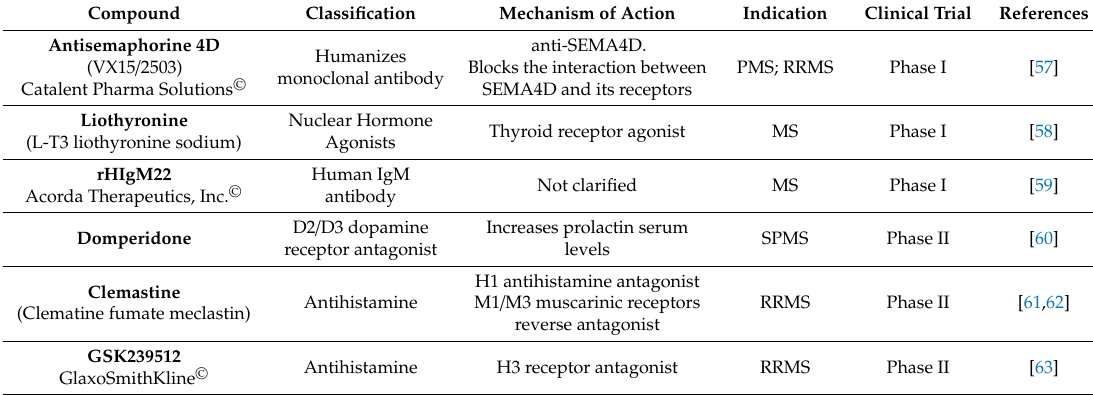
Table 1. Pro-myelinating compounds in ongoing clinical trials for multiple sclerosis (MS) treatment. Semaphorin-4D (SEMA4D); progressive MS (PMS); relapsing-remitting MS (RRMS); secondary progressive MS (SPMS); leucine-rich